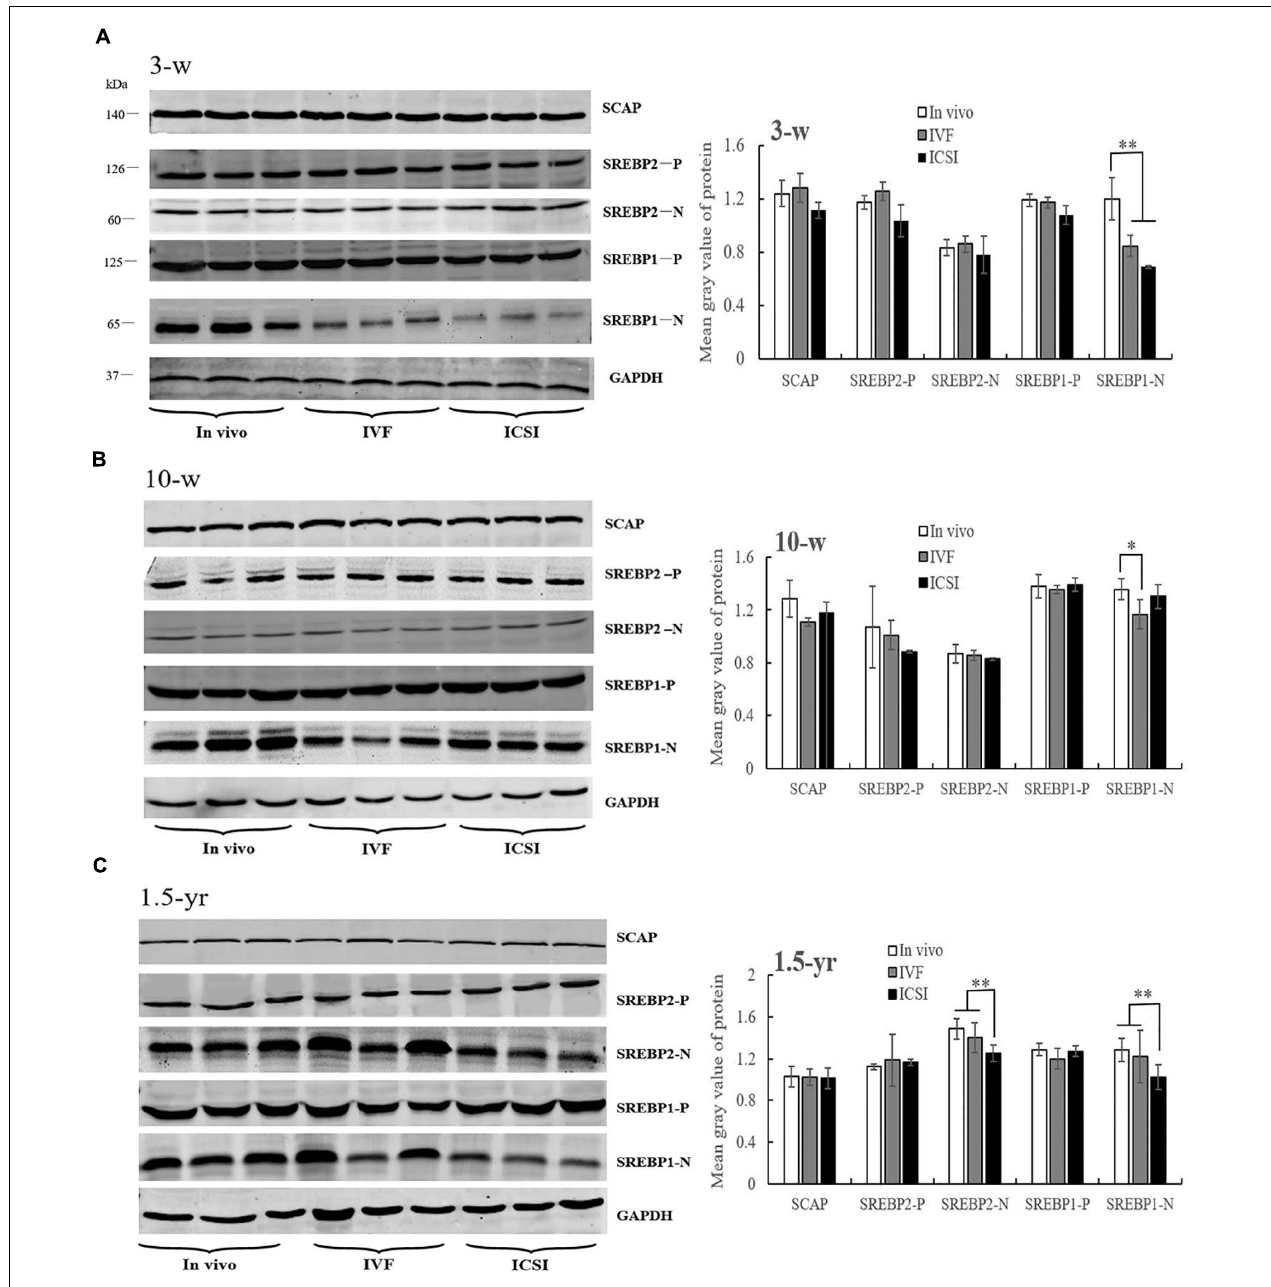
FIGURE 4 | Western blotting analysis of membrane (SCAP and SREBP1/2-P) and nuclear extract (SREBP1/2-N) fractions in the ICSI, IVF, and in vivo mice. Bands of SCAP, SREBPs, and GAPDH and the mean gray value at 3 weeks (A) , 10 weeks (B) , and 1.5 years of age (C) . N, nuclear extract of SREBP; P, precursor form of SREBP. Mean ± SD values are plotted. Between-group comparisons were made by one-way analysis of variance (ANOVA). * P < 0.05, ** P < 0.01. 3-w, 3 weeks; 10-w, 10 weeks; 1.5-yr, 1.5 years